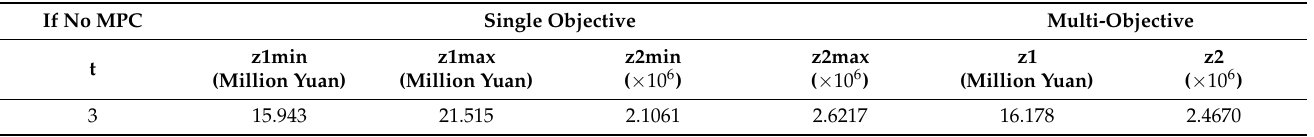
Table 7. Value of objectives without applying